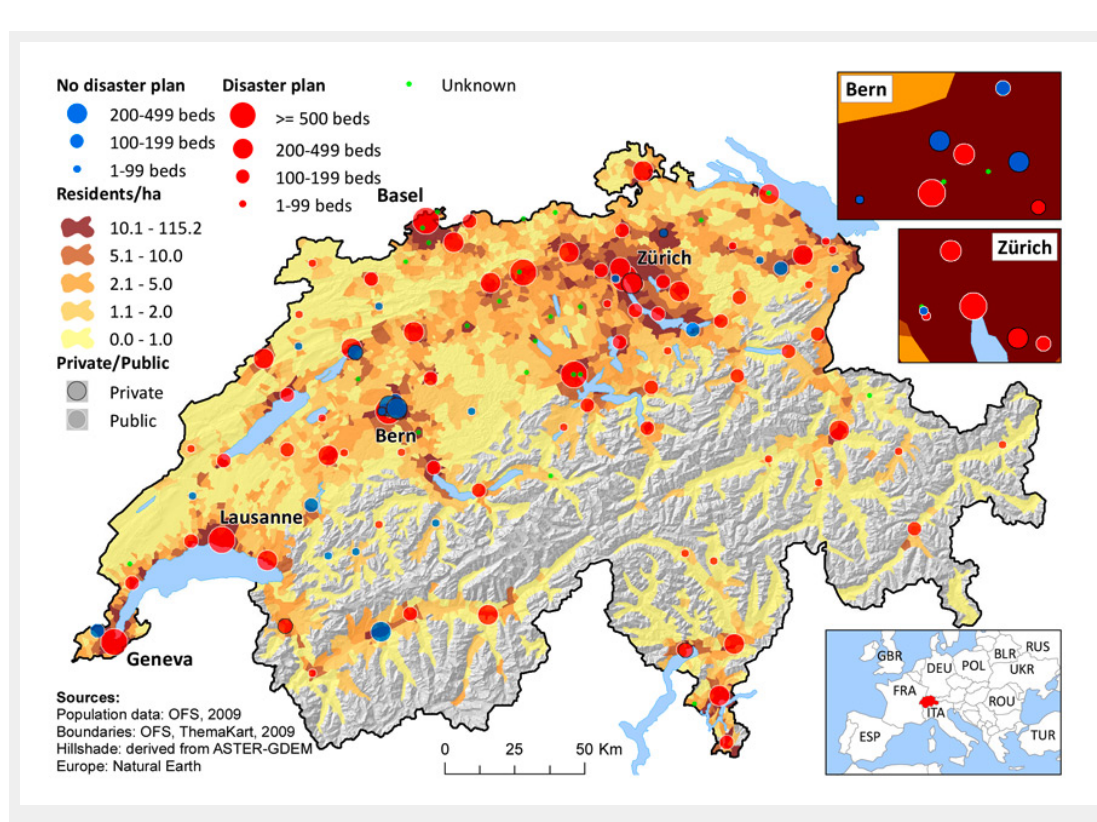
Figure 1 Presence of a hospital disaster plan according to ED and hospital characteristics. (Sources: Population data: OFS, 2009, Boundaries: OFS, ThemaKart, 2009. Hillshade: derived from ASTER-GDEM; Europe: Natural Earth. © Bundesamt für Statistik (BFS), Website Statistik